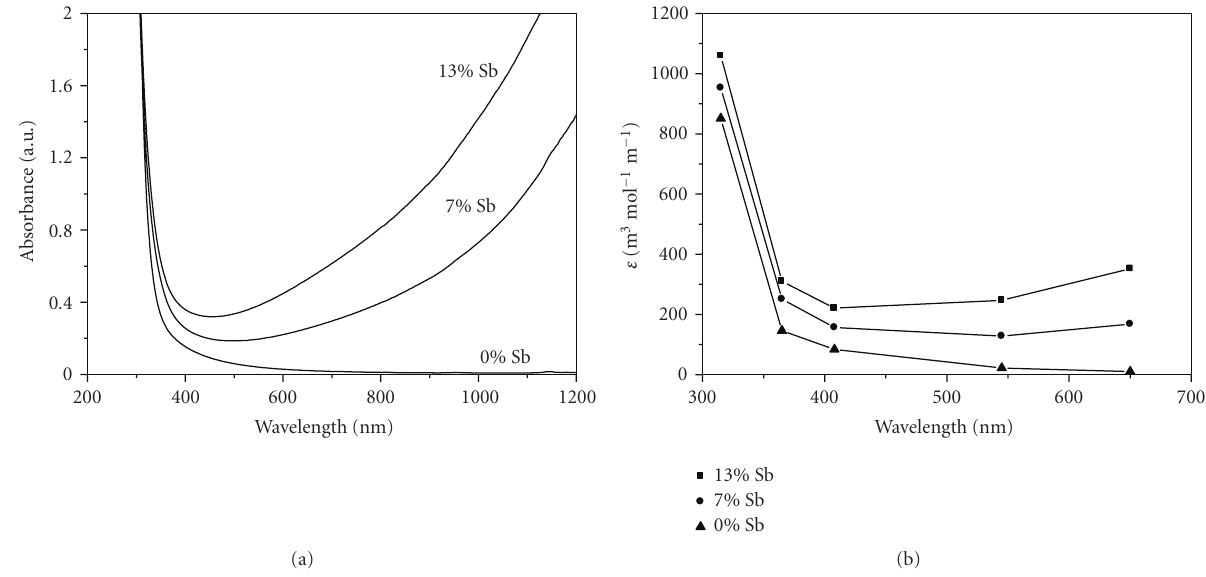
Figure 4: (a) UV/Vis absorbance spectra of ungrafted Sb:SnO 2 (Sb ≥ 0) in aqueous dispersion (0.23wt%). (b) Molar extinction coe ffi cients, ε of Sb:SnO 2 particles at di ff erent wavelengths, not corrected for the Plasmon band